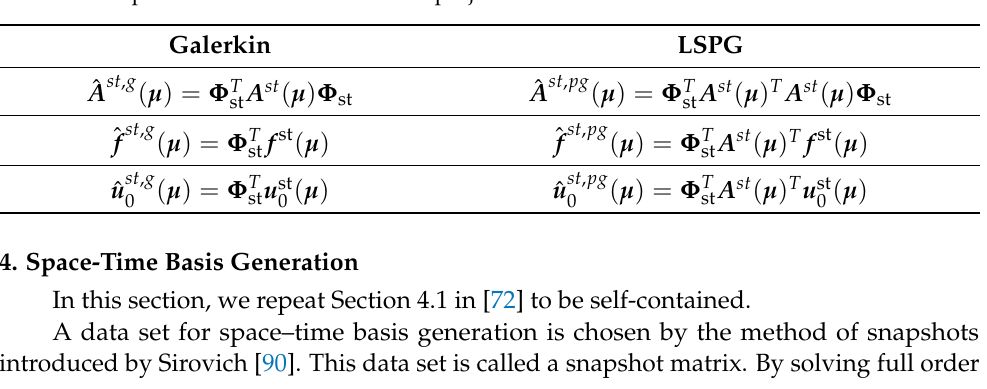
Table 1. Comparison of Galerkin and LSPG